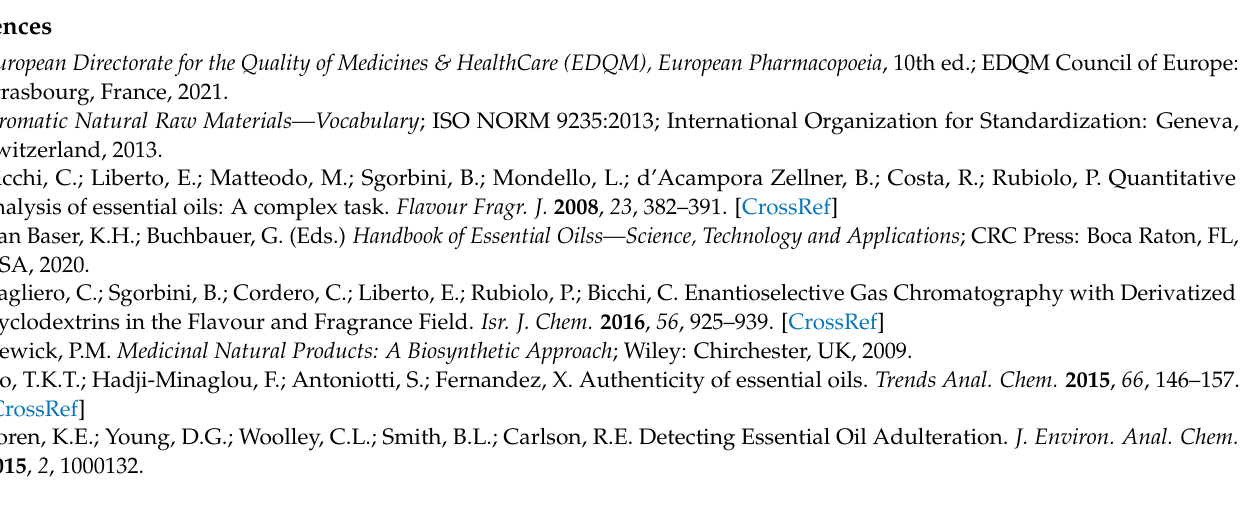
Figure S1. The GC-MS extracted ions of linalool ( m/z = 71) in a bergamot EO, with three consecutive extractions from a sample (on the left) and its linear decay diagram (on the